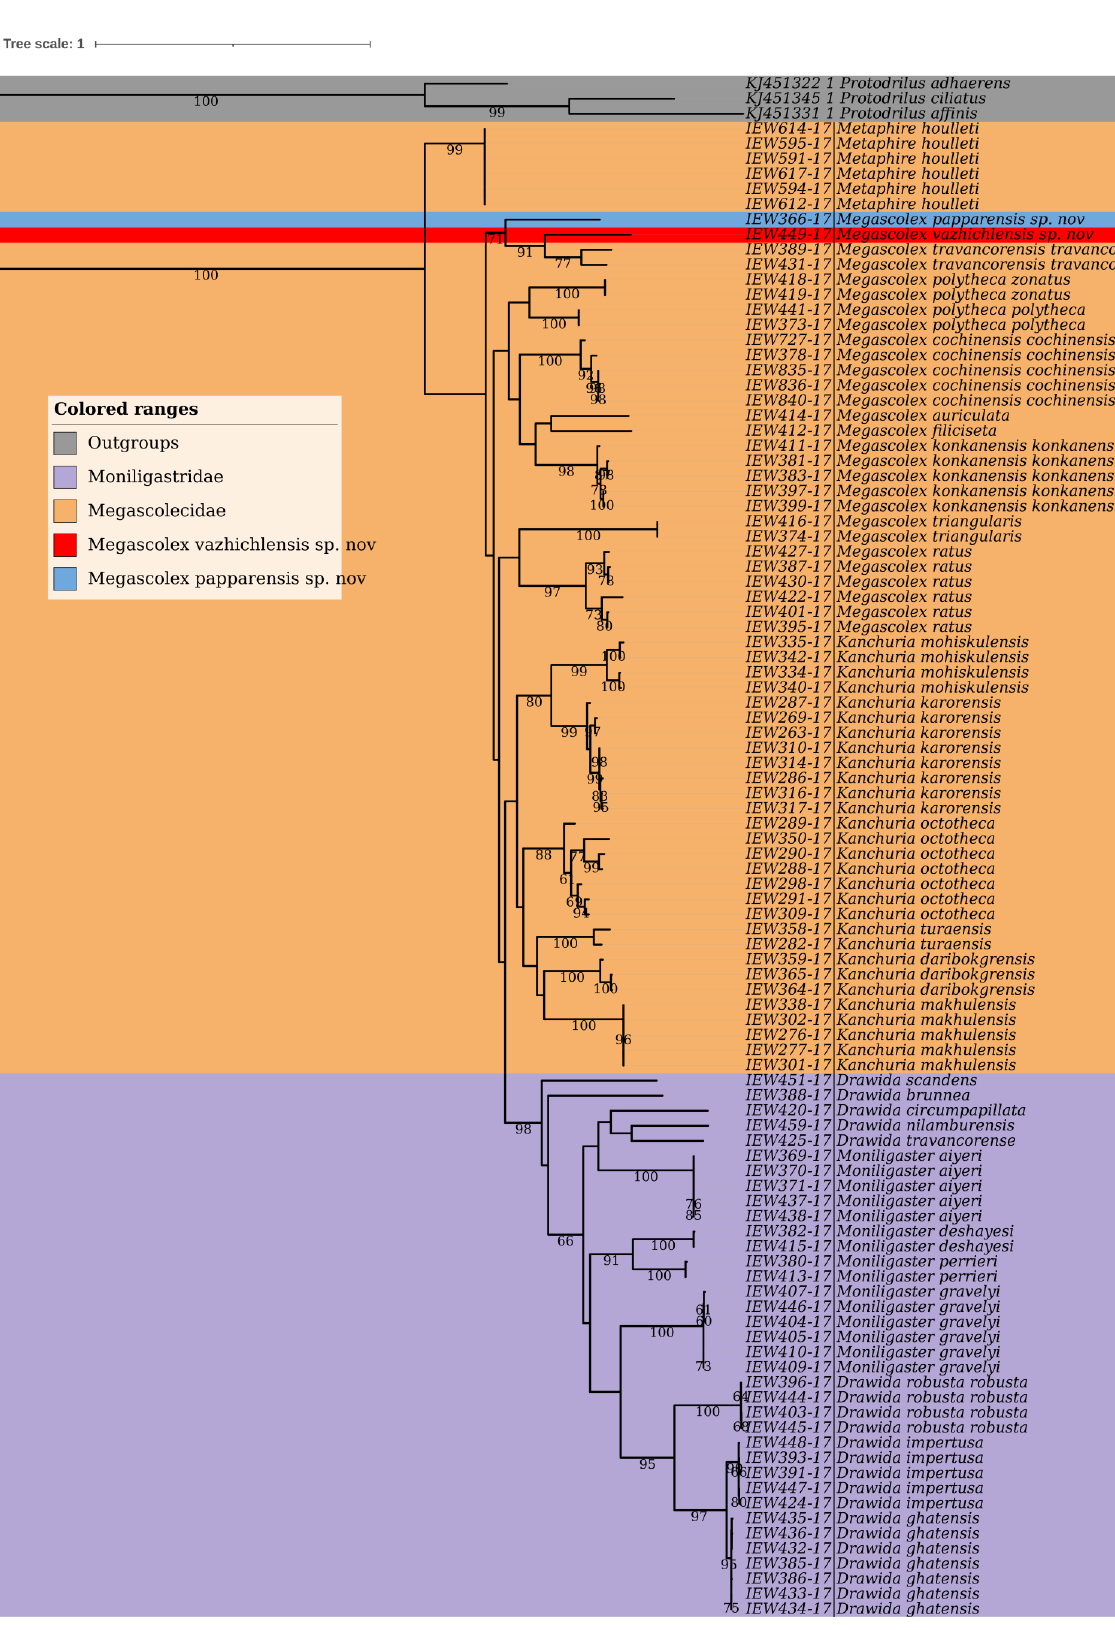
Figure 15. Maximum Likelihood (ML) phylogenetic tree with highest log likelihood ( − 4616.68), containing COI barcodes of earthworm species.